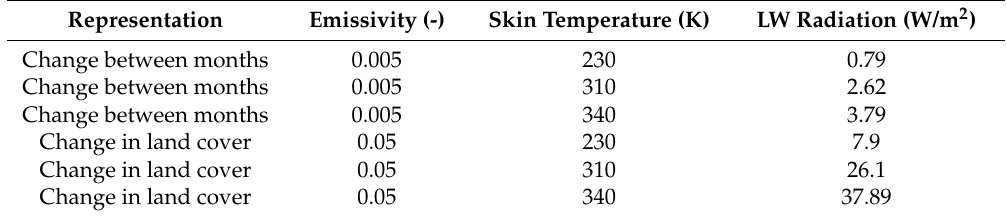
Table 5. Changes in LW radiation shown for various skin temperatures and changes in